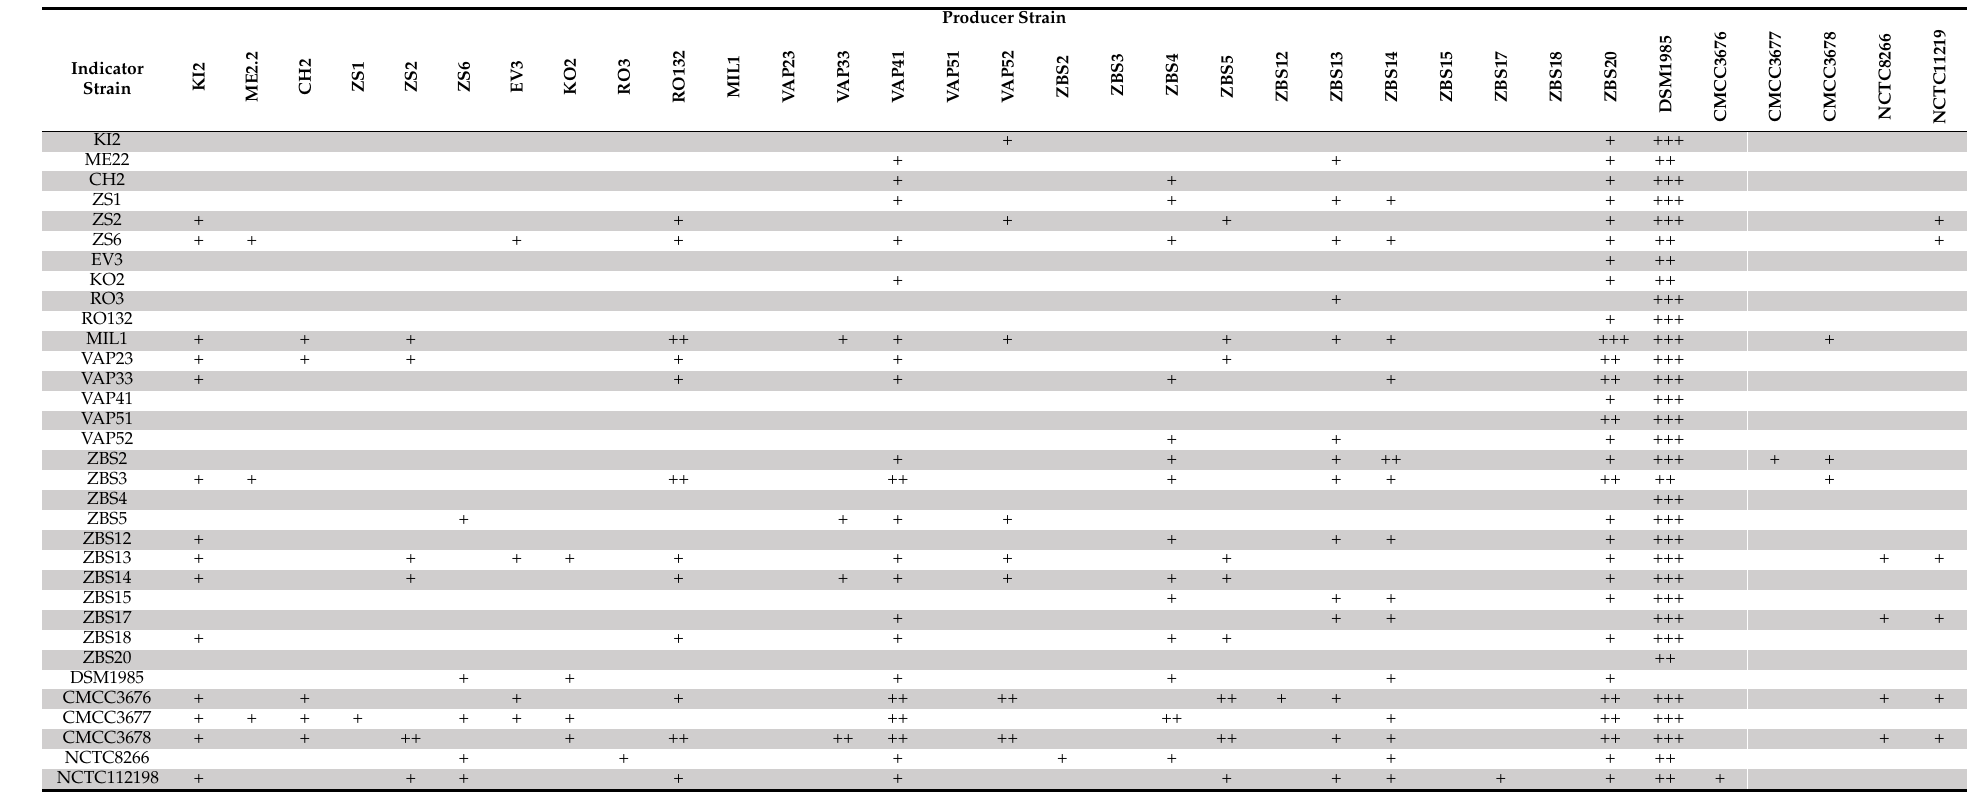
Table 8. Mutual antagonism between all nontoxic isolates, NCTC8266 ∆ bont::ermB and NCTC11219 ∆ bont::ermB based on plate halo assay. Halo size: +: small (<1 mm), ++: medium (1–3 mm), +++: large (>3